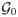
Inhomogeneity in the network and low/moderate gap junctional coupling evoke Ca2+ spirals.The model GD is used. (A) Three regions with higher sensitivity are added on G0, with parameters iJINF,max,j = 1.08, iIP3,max,j = 2.16 and t1,j = 50, for j = 1, 2, 3, creating inhomogeneity (visible at time t = 60). Evolution of ccyt at different time points. Spirals form and then break to stable circles centered around the sensitive zones. (B) The framework of Fig 5, with one more sensitive zone at the center and a non-oscillating region in the upper-left corner of the graph enables spiral formation (parameters of Fig 5).